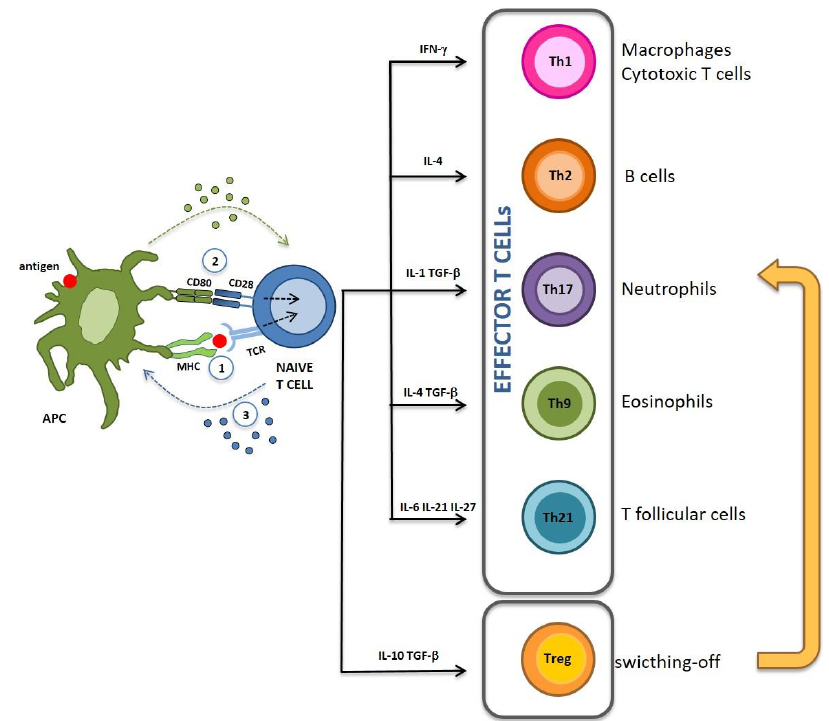
Figure 1. Activation of immune response. Upon activation by APC, naïve T cell depending on the cytokine milieu. are polarized into different T effector cell subsets (Th1, Th2, Th17, Th9, Th21) and into Treg cells, that will switch-off the antigen-specific effector response. Green and blue dotted arrows indicate signal 2 and signal 3.